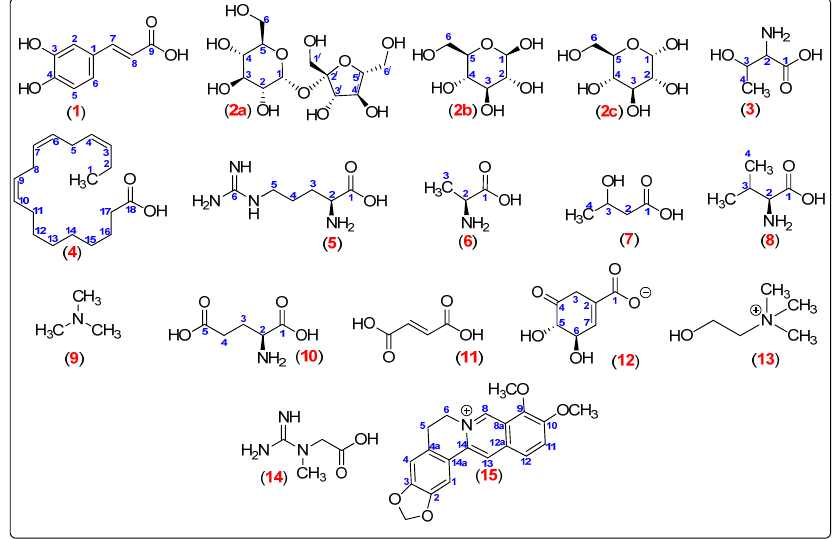
Figure 2. Metabolites identified in the leaves, stems, and roots of Berberis laurina (Berberidaceae).